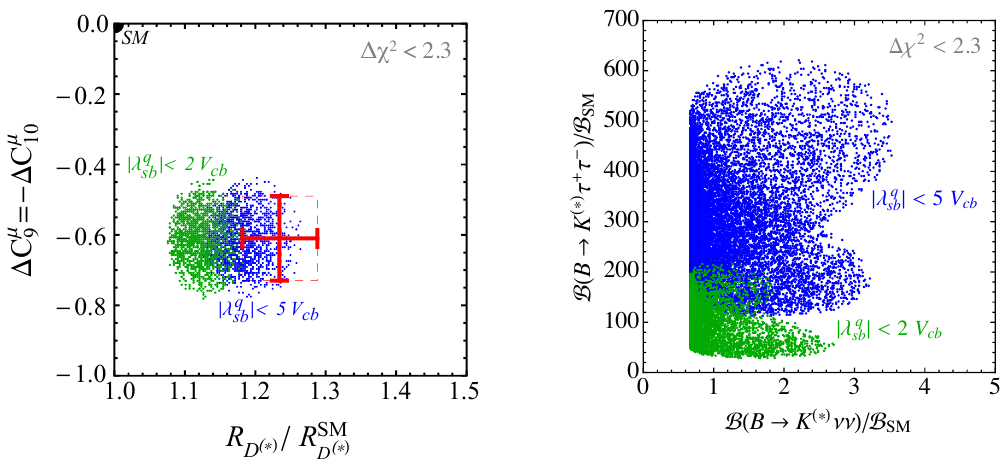
Figure 2 . Left: prediction for (cid:1) C (cid:22) sen set of points within the 1 (cid:27) preferred region of the EFT (cid:12)t: the blue points are obtained setting j (cid:21) q j < 5 j V cb j , while the green points are obtained setting the tighter condition j (cid:21) q sb (cid:12)t. The red cross denotes the 1 (cid:27) experimental constraint. Right: expectations for B ( B ! K ( (cid:3) ) (cid:23) (cid:22) (cid:23) ) and B ( B ! K ( (cid:3) ) (cid:28) (cid:22) (cid:28) ) within the 1 (cid:27) preferred values of the EFT (cid:12)t, again for (cid:21) q (cid:21) q < 2 V cb sb